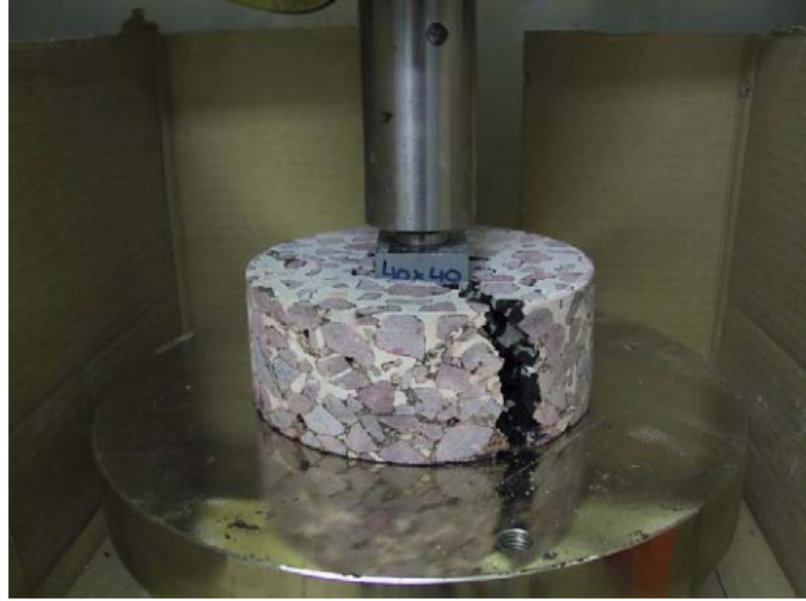
Figure 4. Test setup of indentation strength [57].